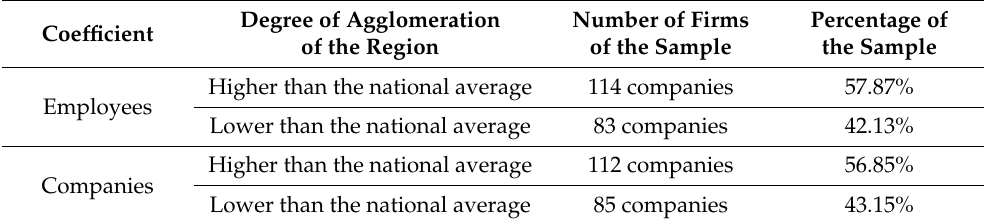
Table 1. Distribution of the sample in relation to the degree of agglomeration of the sector under study, in absolute and relative values.